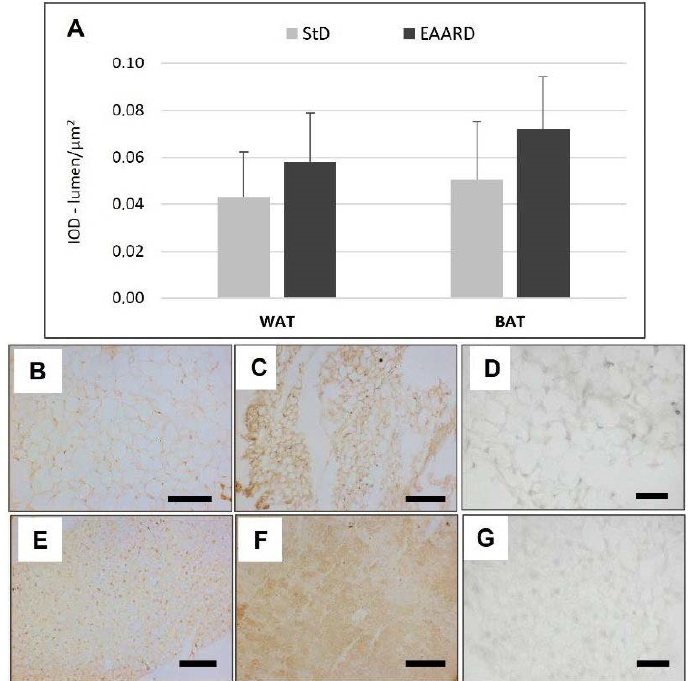
Figure 6. ( A ): Optical density for IL-10 immunostaining in rpWAT ( t = 1.068, p = 0.571) and BAT ( t = 1.615, p = 0.212) according to diet (mean ± sd). Representative images of rpWAT ( B , C ) and BAT ( E,F ) IHC in StD and EAARD-fed mice, respectively. ( D , G ): Negative control performed by omitting the primary antibody. Original magnification 20×; scale bar 100 μm.